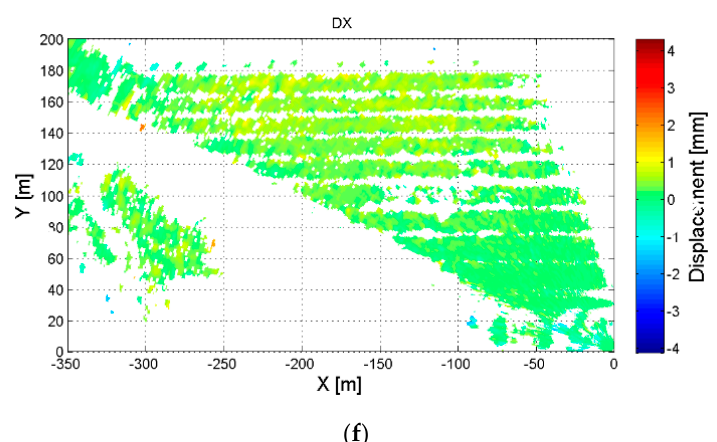
Figure 11. Occhito dam, Carlantino. ( a , b ) photo of the dam as observed from the GBSAR positions; ( c , d ) interferometric coherence ( c , d ); ( e , f ) displacement maps in Cartesian coordinates. Data have been collected by two GBSAR systems installed on the left (SX) and right (DX) downstream sides of the dam, respectively.